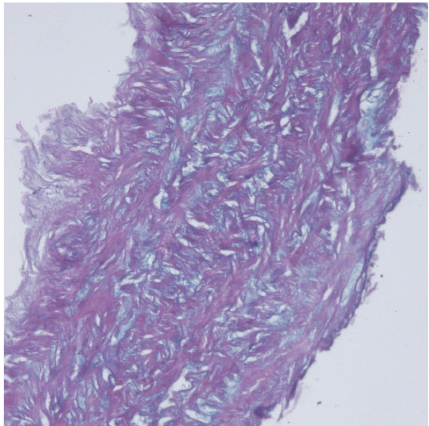
Figure 2: Mucoid degeneration of the LIMA wall. Alcian blue stain ( ×